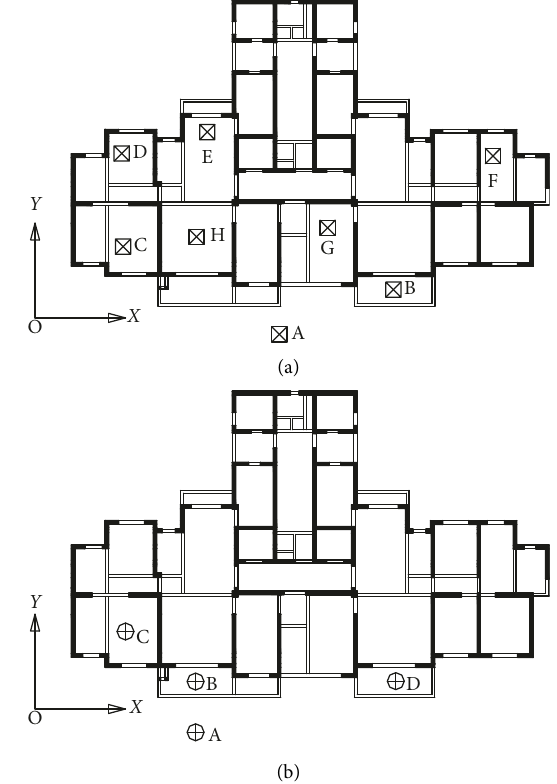
Figure 4: Positions of sensors: (a) acceleration sensors; (b) dis- placement